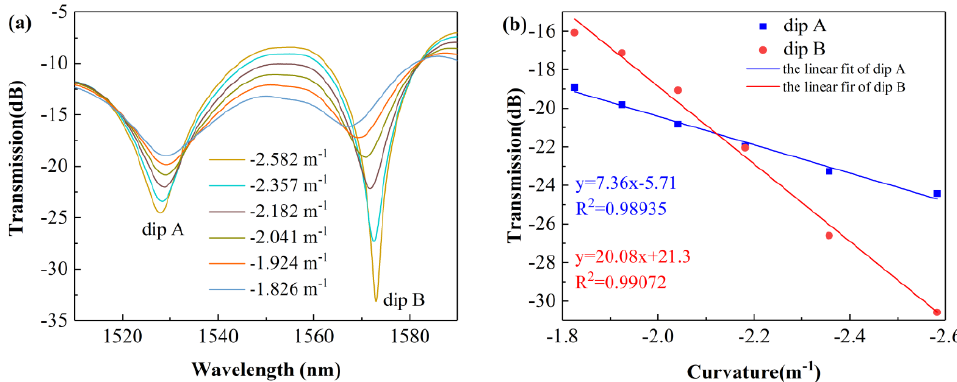
Figure 11. ( a ) Transmitted spectra of the SCSHF sensor under different curvatures; ( b ) linear fitting curve between dip intensity and curvature .